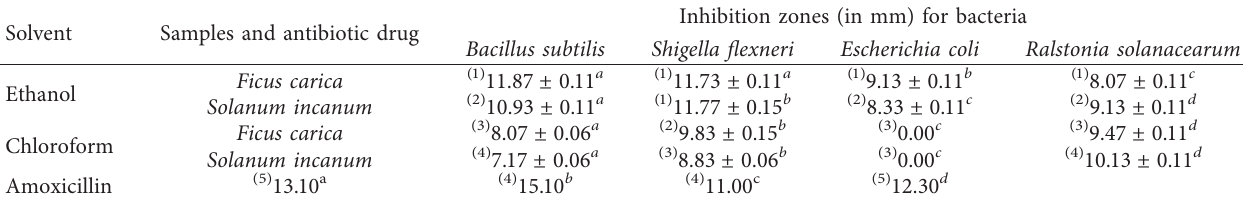
Figure 1: Inhibition zones (in mm) of (a) Ficus carica and AML drug against Bacillus subtilis , (b) Ficus carica and AML drug against Shigella flexneri , and (c) Solanum incanum and AML drug against Bacillus subtilis bacteria. Table 6: Inhibition zones, including well diameter, of samples against bacterial growth.